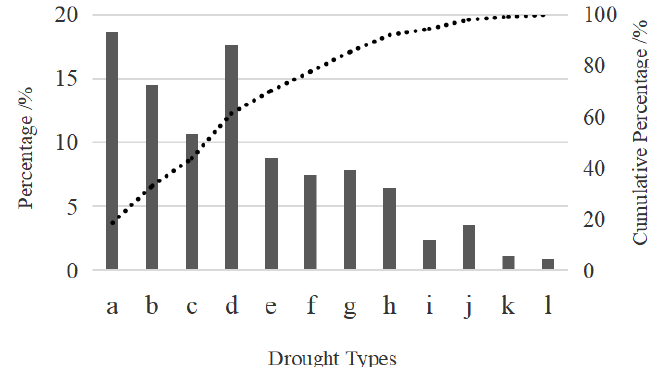
Figure 6. Percentage distribution and cumulative percentage distribution of different types of